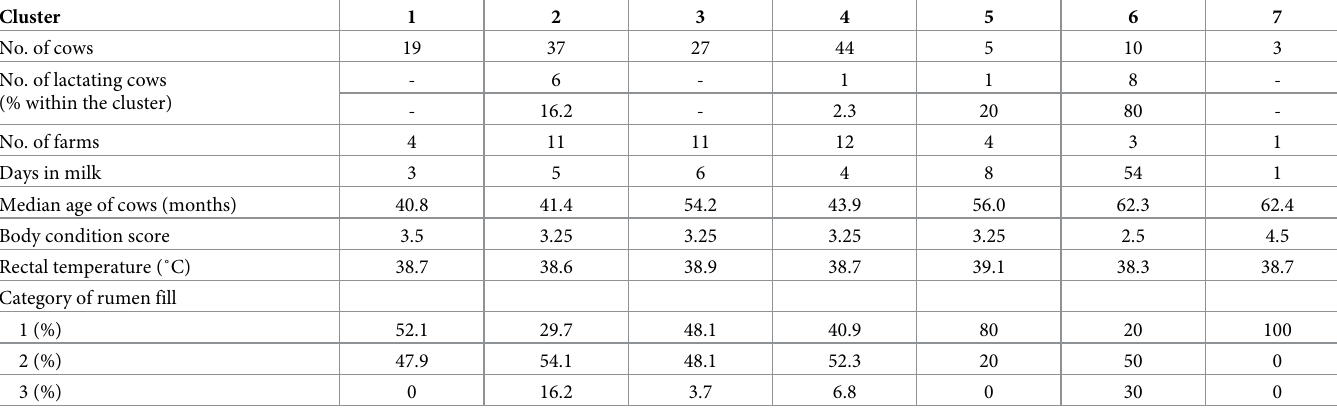
Table 3. Assignment of examined cows to the clusters and their clinical characterization (median values or percentages). Cluster